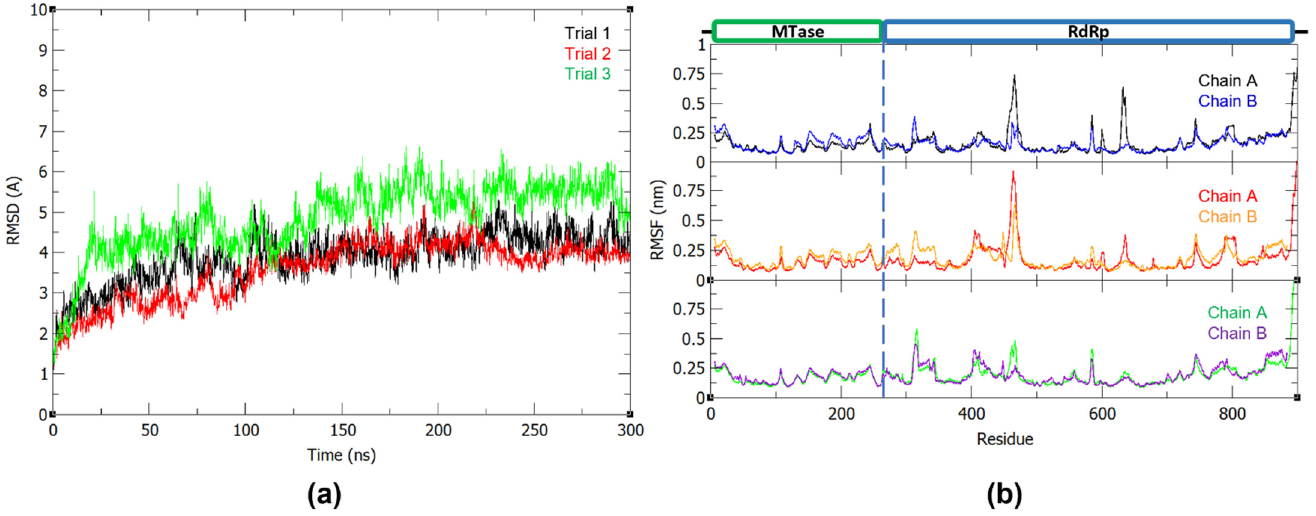
Figure 1. ( a ) Backbone RMSD plot of the three 300 ns dengue NS5 production runs and ( b ) RMSF plot of the dengue NS5 protein chain A and B with trial 1, trial 2, and trial 3 in the first, middle, and last panel, respectively. Table 1. Hydrogen bond donor and acceptor occupancy within the NS5 protein for three production trials. “Main” signifies that the main chain or the backbone participates in hydrogen bonding, while “Side” signifies that the residue side chain participates in hydrogen bonding.